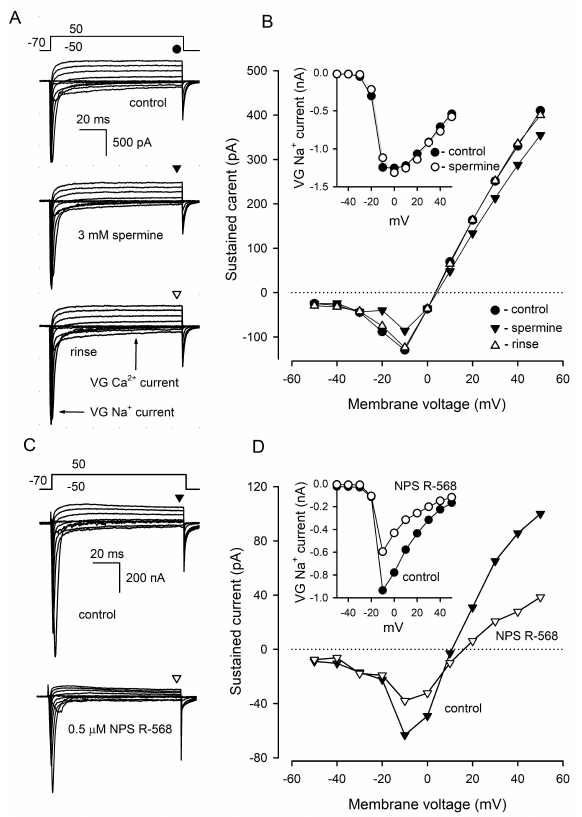
Figure 5. Effects of CASR agonists on VG currents in type III cells. ( A ) Representative ( n = 9) recording of integral VG currents in a type III cell in control (upper panel) in the presence of 3 mM spermine (middle panel) and after rinse of the CASR agonist (bottom panel). The cell was held at − 70 mV and polarized from − 50 to 50 mV by 100 ms voltage pulses with 10 mV increment. Leak currents were subtracted using the P/4 protocol. The patch pipette contained 140 mM CsCl and amphotericin B (400 µ g/mL), the bath solution contained 140 mM NaCl and 2 mM CaCl 2 . The sustained VG currents were evaluated in the moments indicated by the symbols above the current traces. ( B ). I–V curves of the sustained VG currents shown in ( A ). The inset, I–V curve for VG Na + current recorded in